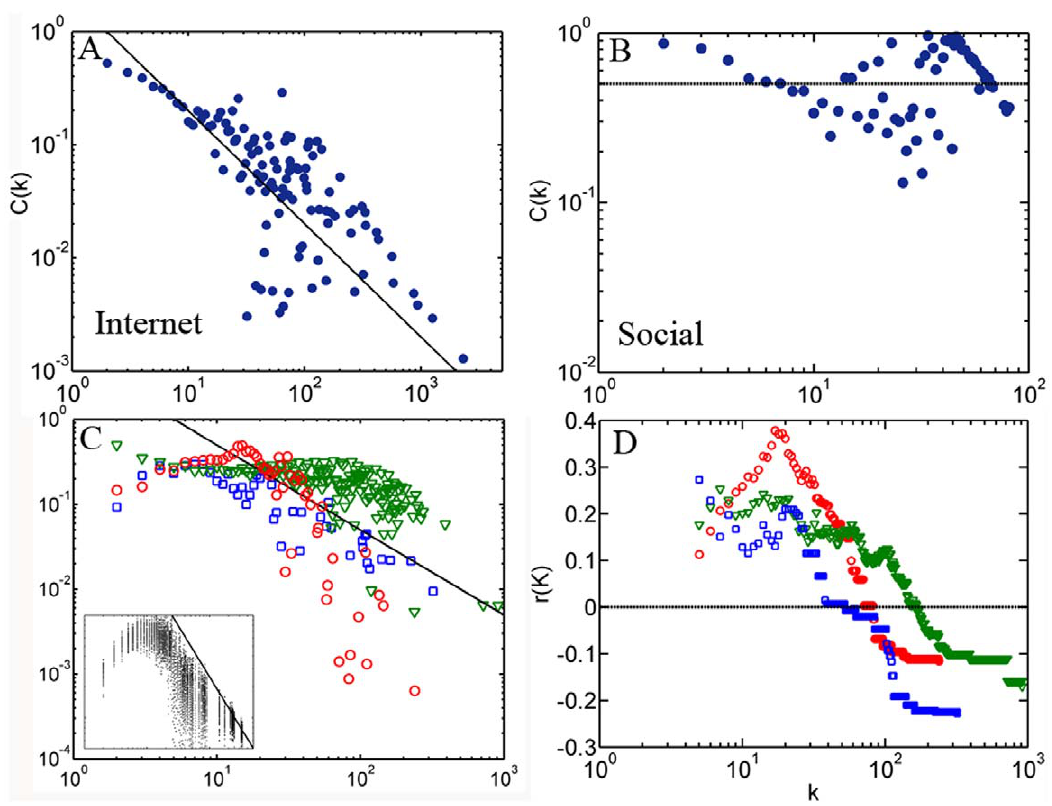
Figure 4. The dichotomy of degree correlation and its reflection on clustering coefficient distribution. The clustering coefficient distribution of Internet at AS level ( A ) and social network of co-authored relationship ( B ). C . The sickle-shaped C(k) curve of biological networks: PIN of HC dataset (red), GIN (green) and yeast metabolic network (blue). The inset displays the C(k) curves of 100 random dichotomized networks (each containing 10,000 nodes with P ( k ) , k 2 2.4 , of which links of the top 0.5% best connected nodes are disassortative while those of other nodes are assortative). D . The assortative coefficient curves r ( k ) for the three biological networks. In A , C and D , the solid lines correspond to C ( k ) , k 2 1 , which are drawn to compare with the hierarchical